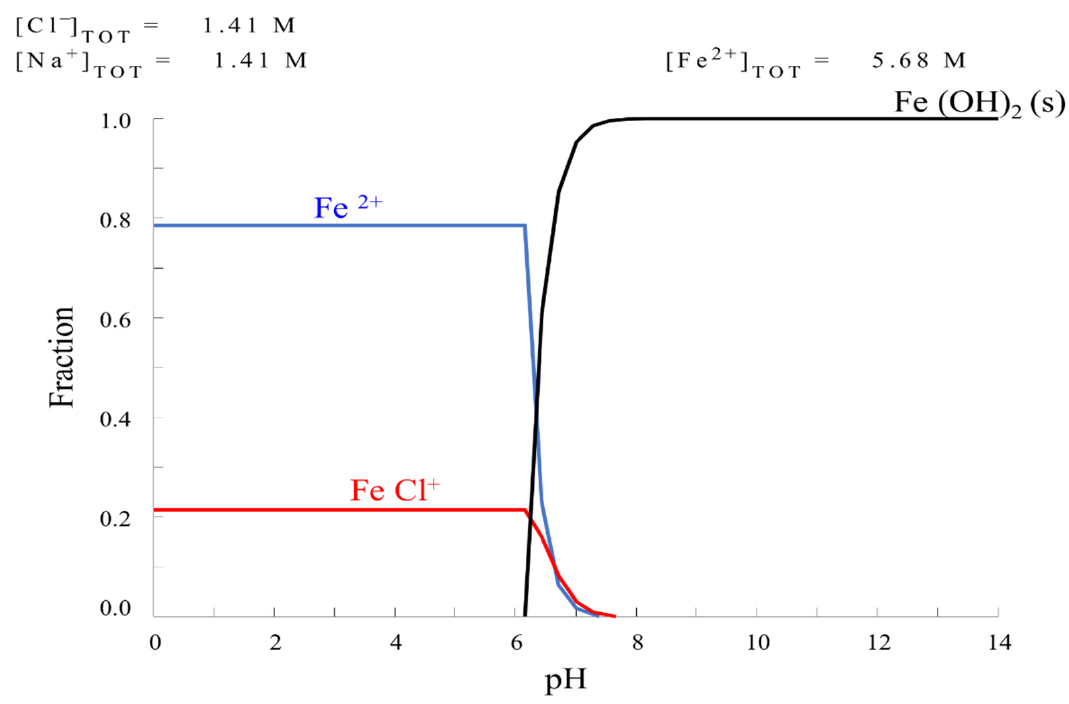
Figure 1. Chemical equilibrium diagram for solution iron/chlorine ratio at 0.25.